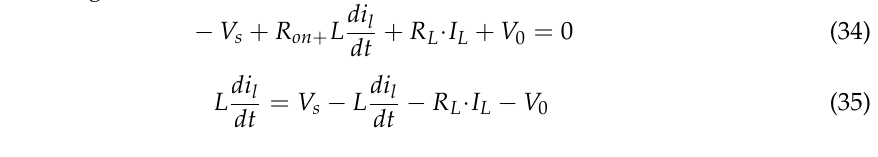
Figure 26. Linearized DC–DC buck converter model.